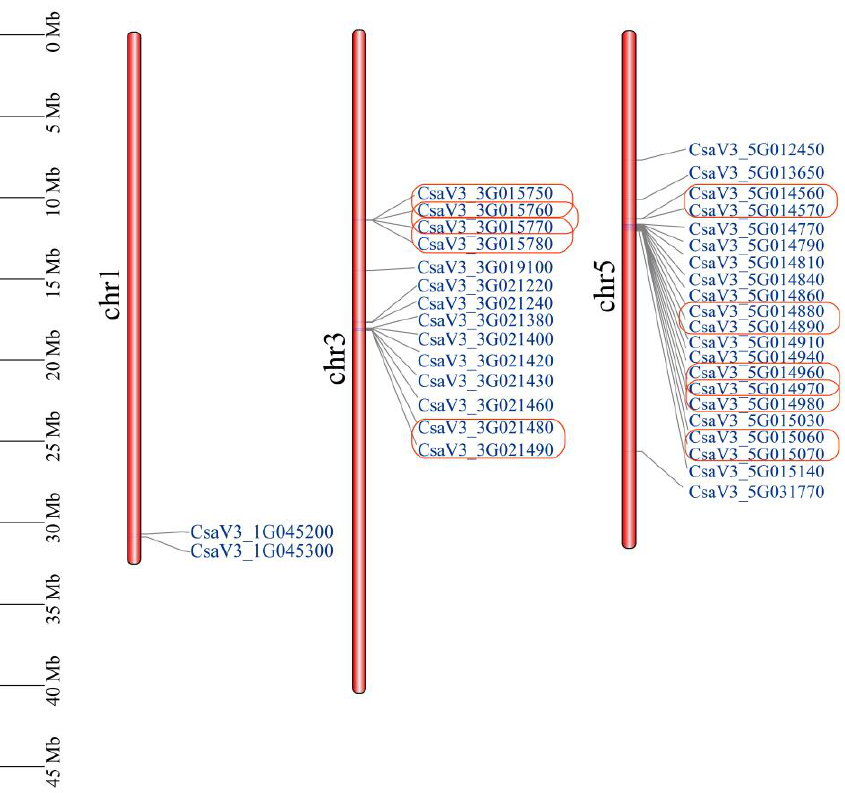
Figure 1. Chromosomal map and duplication events of CsMLP genes. Tandem duplication was indicated by red boxes.